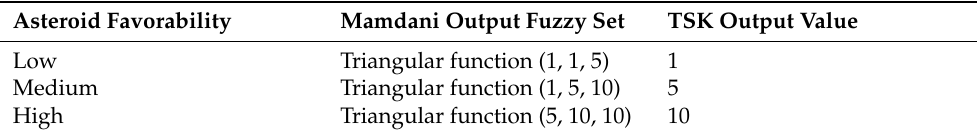
Algorithm 2: XAI Core Execution Time Benchmark